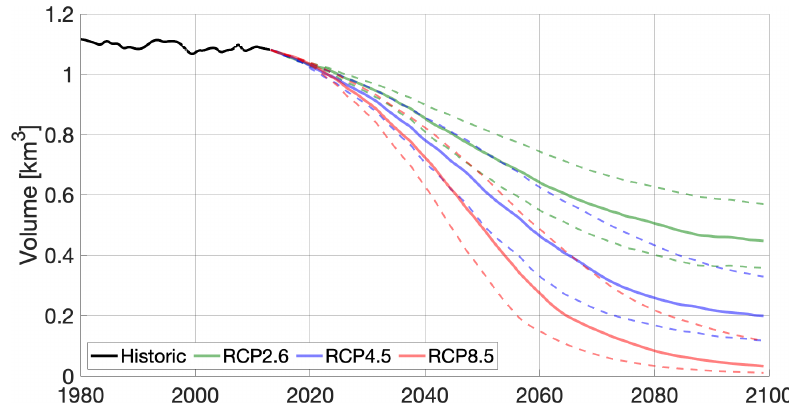
Figure 8. Volume evolution for different gradients between ELA and temperature, with the mean shown in solid lines and the 1 σ confidence interval indicated by dashed